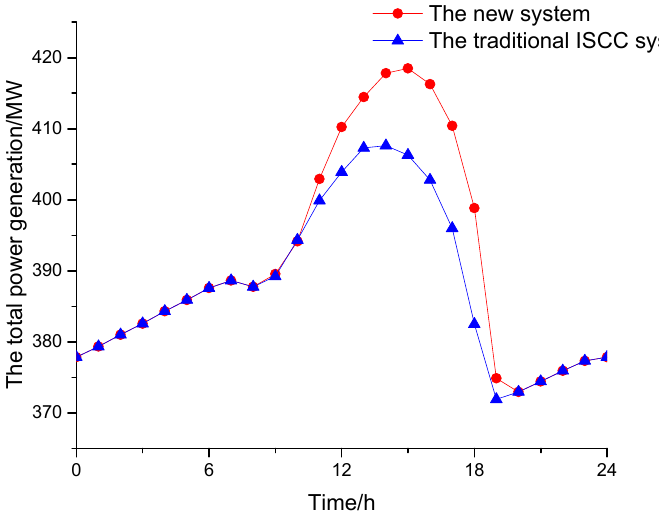
Figure 11. The total power generations of the traditional ISCC and the new system in a typical summer day.